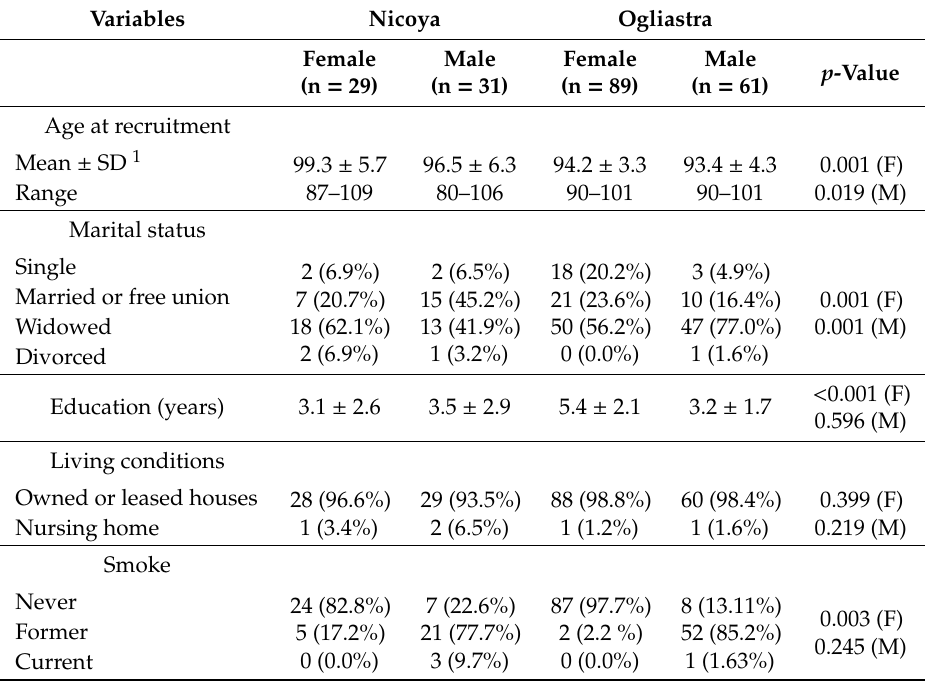
Table 1. Sociodemographic characteristics of the subjects from Nicoya and Ogliastra recruited for the